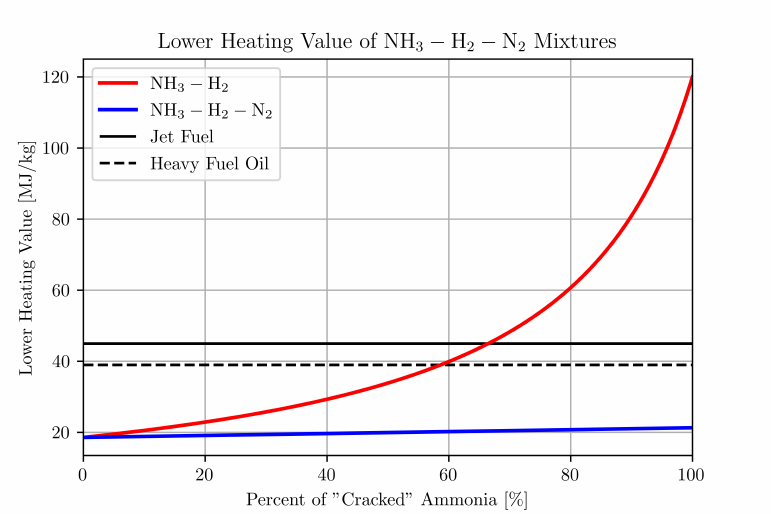
Figure 2. The lower heating values (LHVs) of NH 3 -H 2 and NH 3 -H 2 -N 2 mixtures as a function of the percent of cracked ammonia